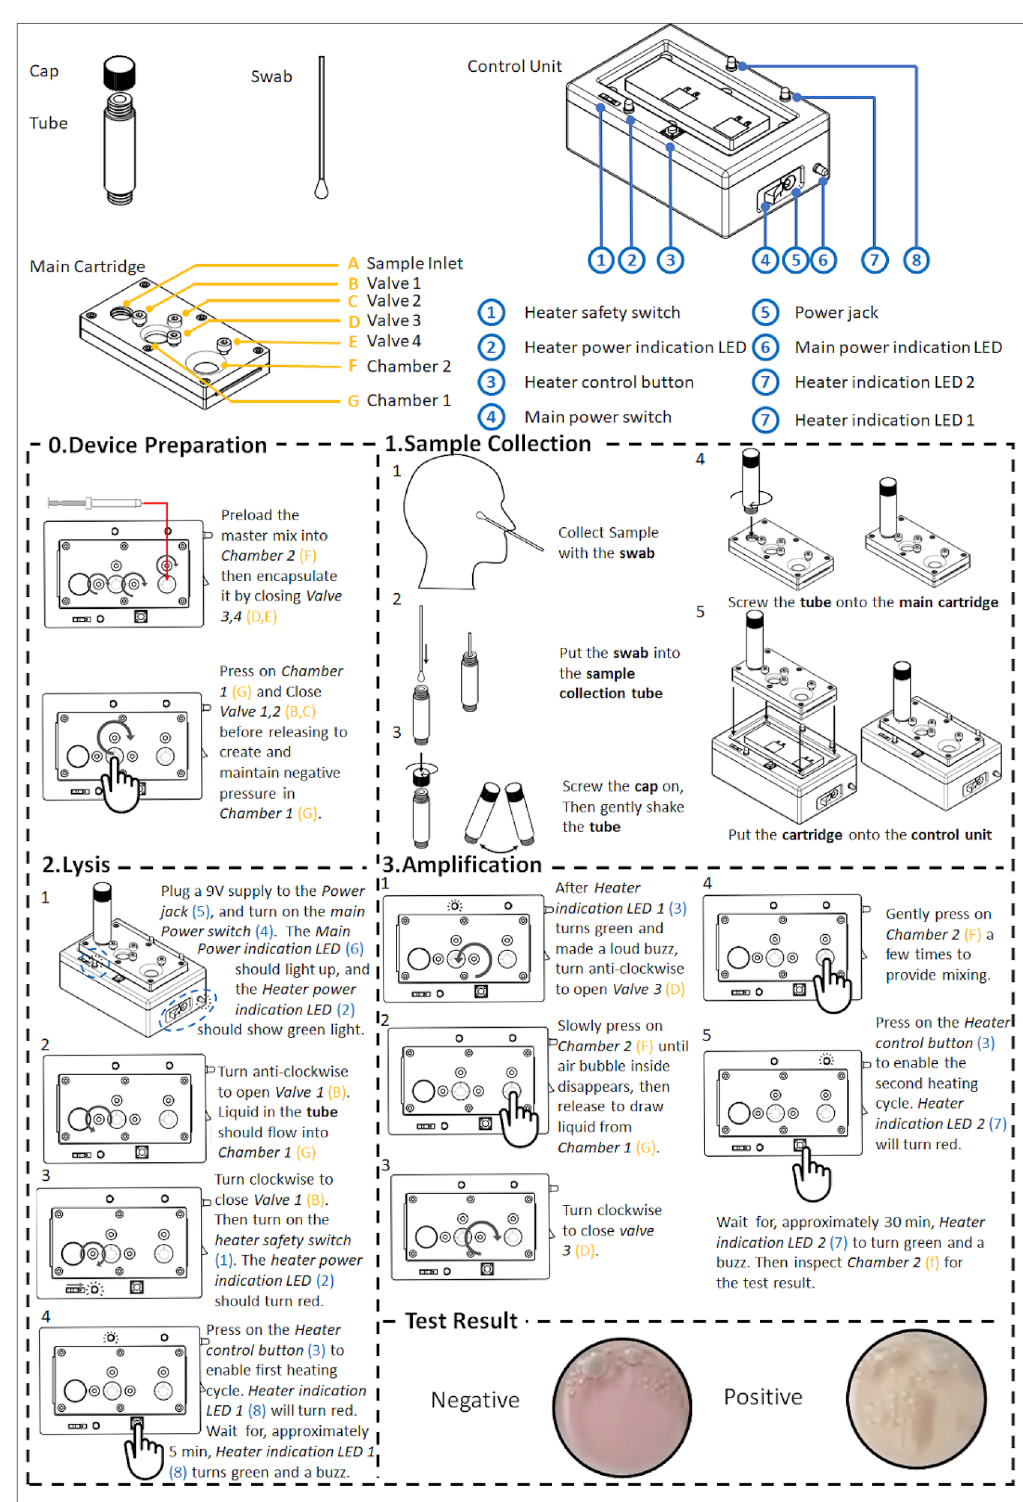
Figure 8. Step-by-step operating procedure of the